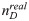
Plot of drive nodes of real, rand-Degree and rand-ER network (a) before (nDreal, nDrand-Degree, nDrand-ER) and (b) after optimization by EOOC (nDreal(opt), nDrand-Degree(opt), nDrand-ER(opt)), and (c) the faction of critical, redundant and intermittent edge direction of 14 real networks.